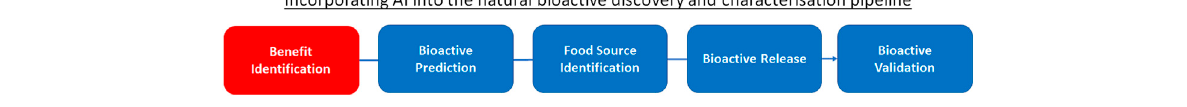
FIGURE 2 | Integrating AI into the natural bioactive discovery and characterisation pipeline. Speci fi c health bene fi ts or replacement needs (red) are targeted at the beginning of the process. AI integration allows for prediction of bioactives with pre-speci fi ed health bene fi ts and subsequent selection of a most suitable source, which contains an abundance of these bioactives, plus bioactivity con fi rmation